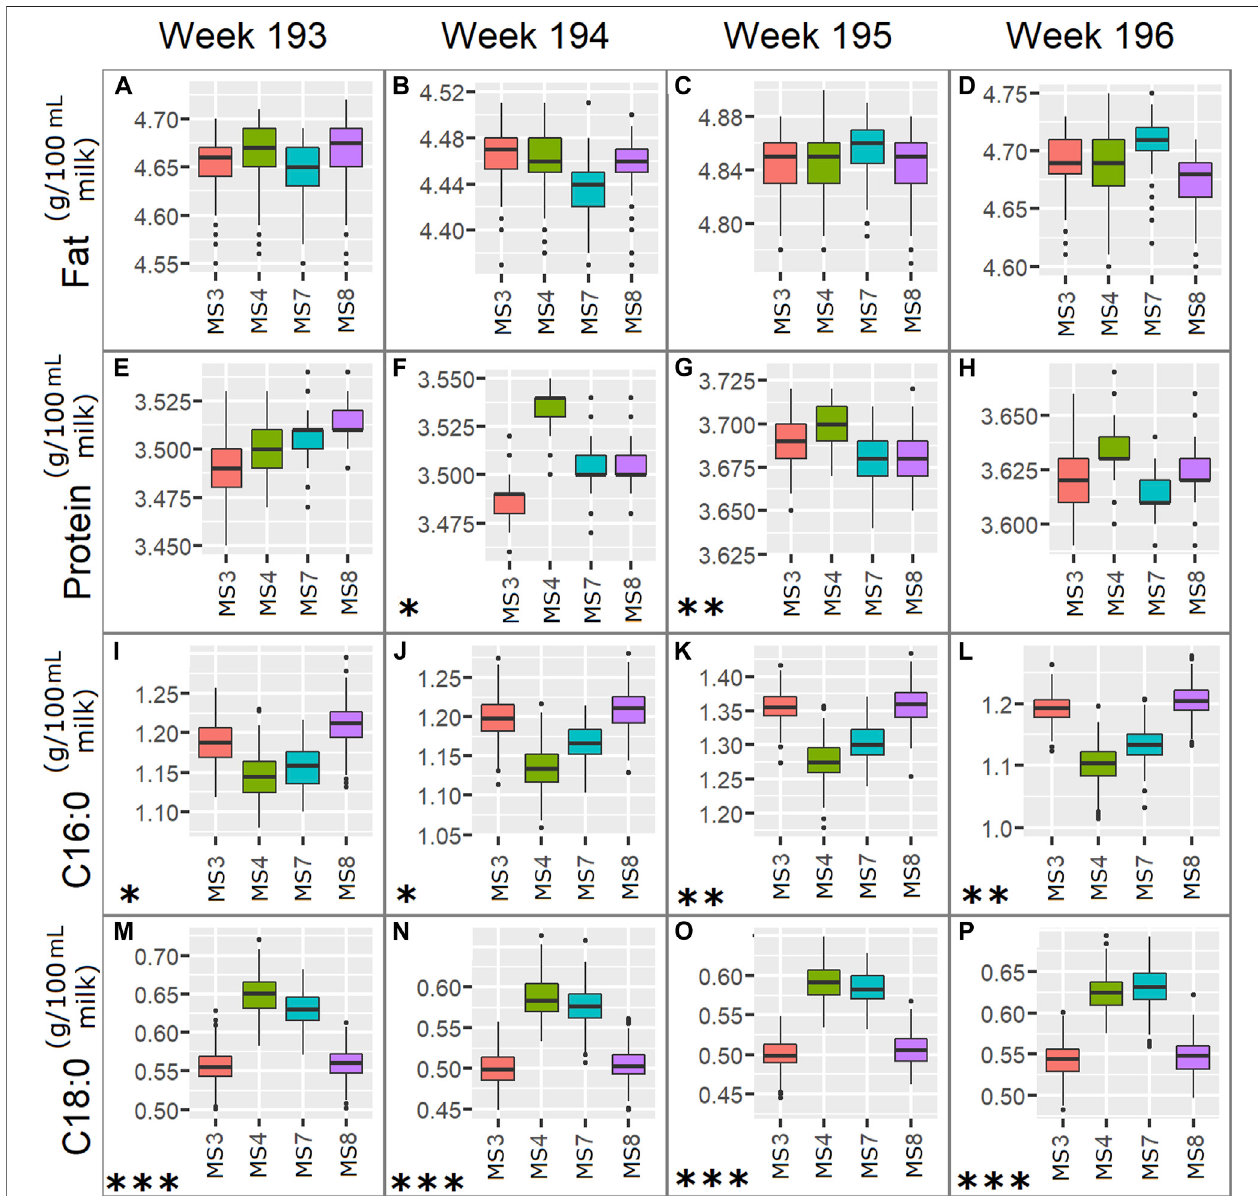
FIGURE7| Boxplots forfat, true protein, C16:0andC18:0predicted from pilotspectrausing instrumentsMS3, MS4,MS7, and MS8,over successiveweeksthat had low TSSQ: week 193: (A) Fat, (E) True protein, (I) C16:0, (M) C18:0; week 194: (B) Fat, (F) True protein, (J) C16:0, (N) C18:0; week 195: (C) Fat, (G) True protein, (K) C16:0, (O) C18:0and week196: (D) Fat, (H) True Protein, (L) C16:0, (P) C18:0.Theplots foreach weekshow themedian, IQRand variability outsidetheupper and lower quartiles for each component. Asterisks represent the number of SD ’ s, marked * for 1SD, ** for 2SDs and *** for 3SDs, by which the predicted component exceeds the average of all 177-weeks average